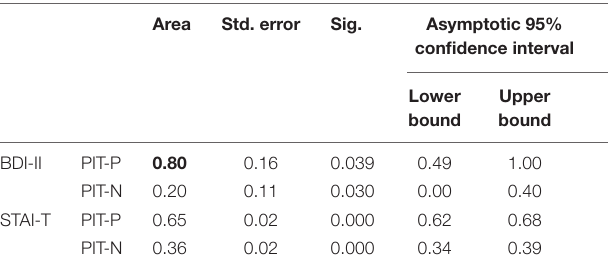
confidence interval Lower Upper bound